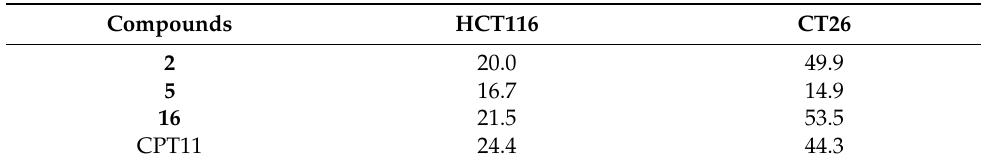
Table 2. Cytotoxicity of compounds (IC 50 values in µ M).